Question: What does this figure show? Answer in one sentence.
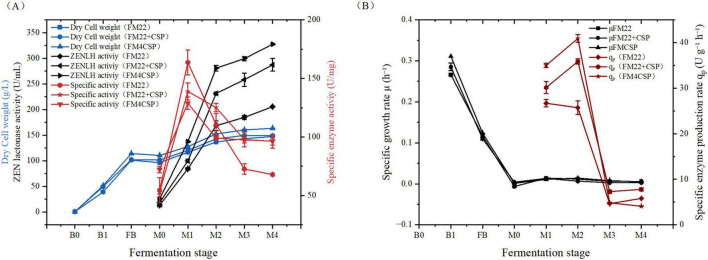
Answer: Scale-up fermentation of ZEN lactonase in a 30 L bioreactor: (A) cell growth and ZEN lactonase production profiles; (B) kinetics of specific growth rate and specific enzyme production rate. FM4CSP increased ZEN lactonase activity by 1.59-fold (327.56 U/mL) compared with conventional FM22 (205.52 U/mL), and CSP supplementation enhanced the specific production rate ( q p ) during the high-production phase.